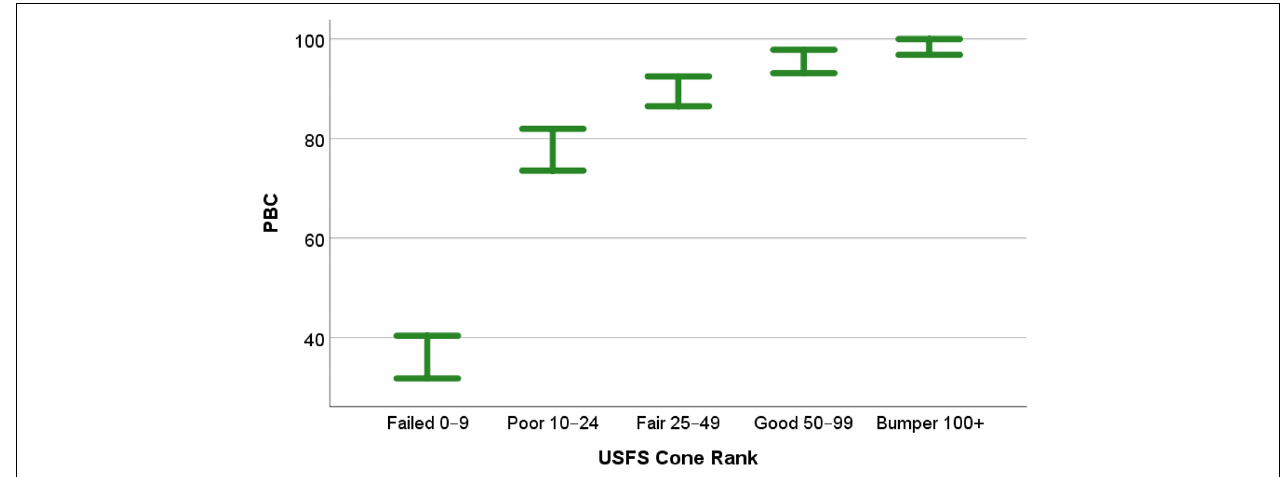
FIGURE 4 | Error plot (95% confidence intervals) for the one-way ANOVA analysis of PBC categorized by USFS cone-class ( n = 314). Average number of cones per tree as follows: Failed = 0–9 cones, Poor = 10–24 cones, Fair = 25–49, Good = 50–99, and Bumper ≥ 100.